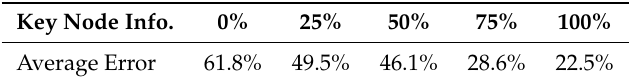
Table 1. Errors vs. key node information percentage ( SR = 0.33). Key Node